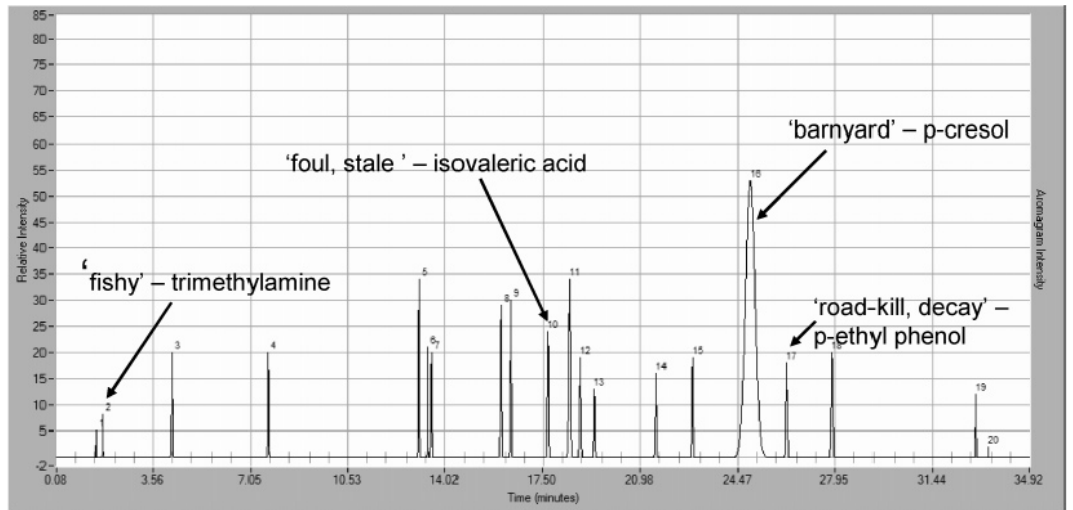
Figure 10. Aromagram for 4 h SPME fiber collection 2,000 m downwind (―distant‖ site) from commercial beef cattle feed yard (reprinted from [193] with permission from